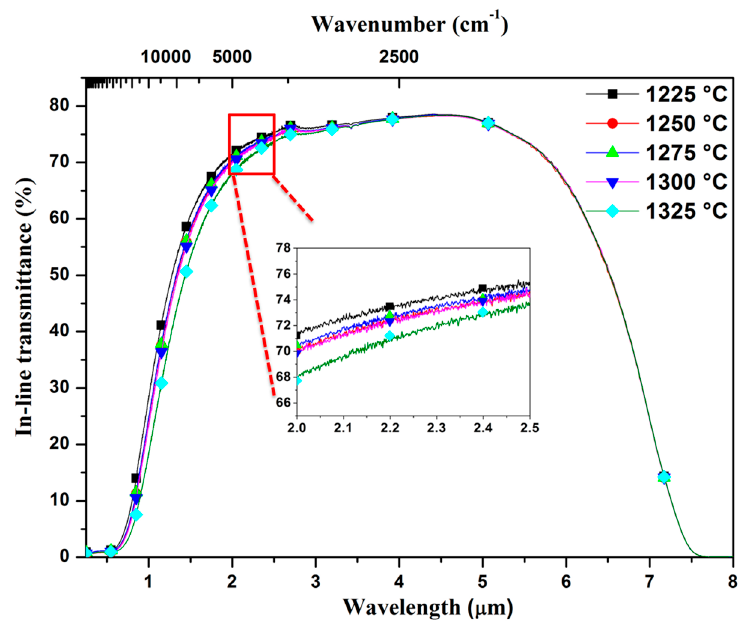
Figure 5. Influence of pre-sintering temperature on the in-line transmittance of 3Y-TZP ceramics HIPed at 1275 °C. Inset: the amplified in-line transmittance micrographs range from 2 μ m to 2.5 μ m.